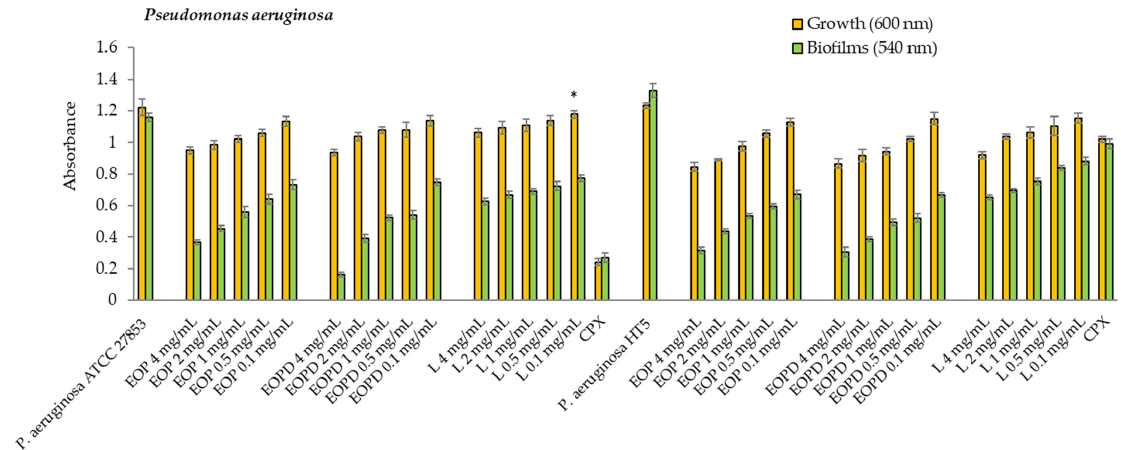
Figure 5. Growth and biofilms of Pseudomonas aeruginosa (ATCC 27853 and HT5 strains). EOP: Essential oil obtained by cold-pressed method; EOPD: essential oil obtained by cold-pressed method